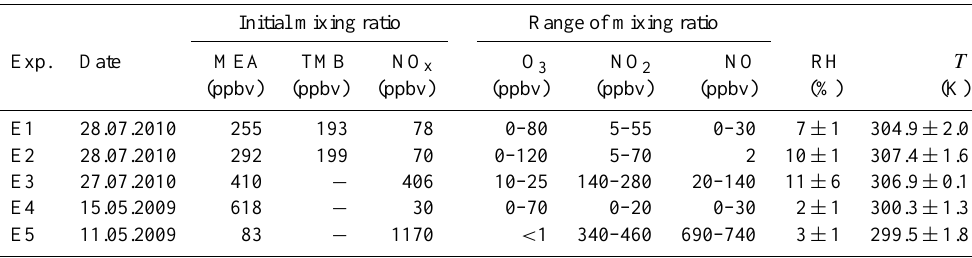
Table 1. Initial mixing ratios of reactants (at start of the experiment), ranges of the mixing ratios of O 3 , NO, NO 2 , average relative humidity and average temperature in the MEA photo-oxidation experiments. Initial mixing ratio Range of mixing ratio